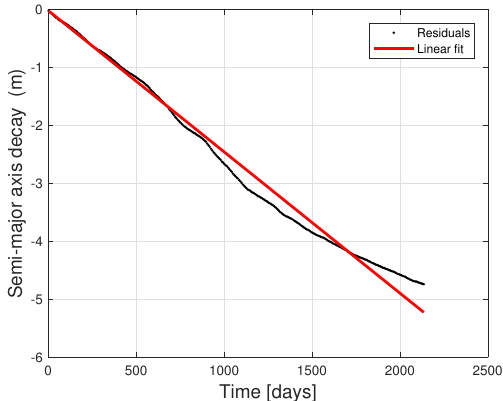
Figure 4. Semi-major axis decay of LARES over a time span of 2135 days (about 5.8 years). The black dots represent the integrated residuals of the satellite semi-major axis. The residuals have been determined [57] by comparing the measured values with the predictions of a precise orbit determination (POD) obtained with GEODYN II. The dynamical model of GEODYN neither includes the neutral and charged atmosphere drag, nor the thermal effects. The red line represents a linear fit to the integrated residuals and yields a decay of about 2.44 ± 0.02